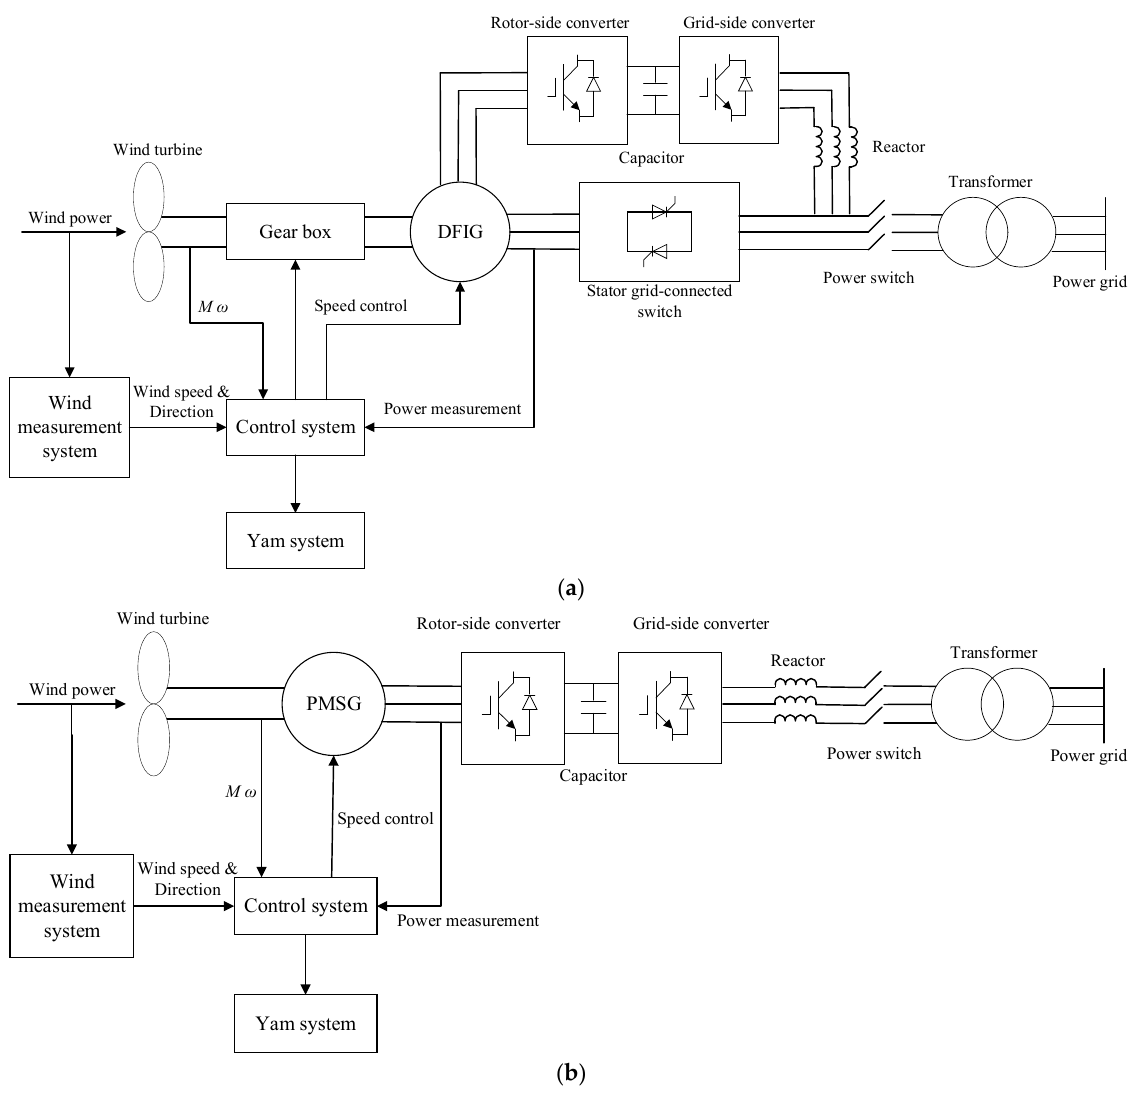
Figure 5. Energy flow and information flow in offshore wind turbines. ( a ) DFIG; ( b ) PMSG.